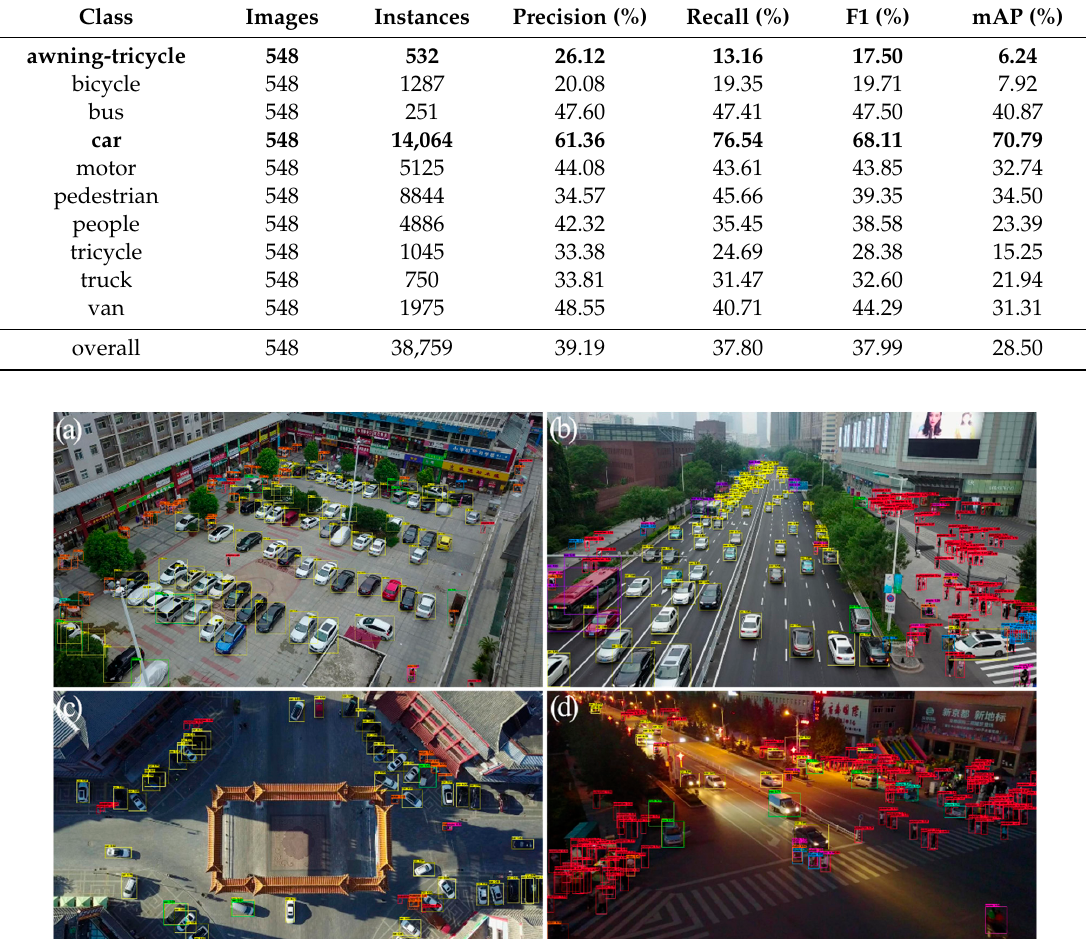
detection results for a single category of the remote-sensing image ShipData set. A portion of the detection results for Mixed YOLOv3-LITE in the first experiment is shown in Figure